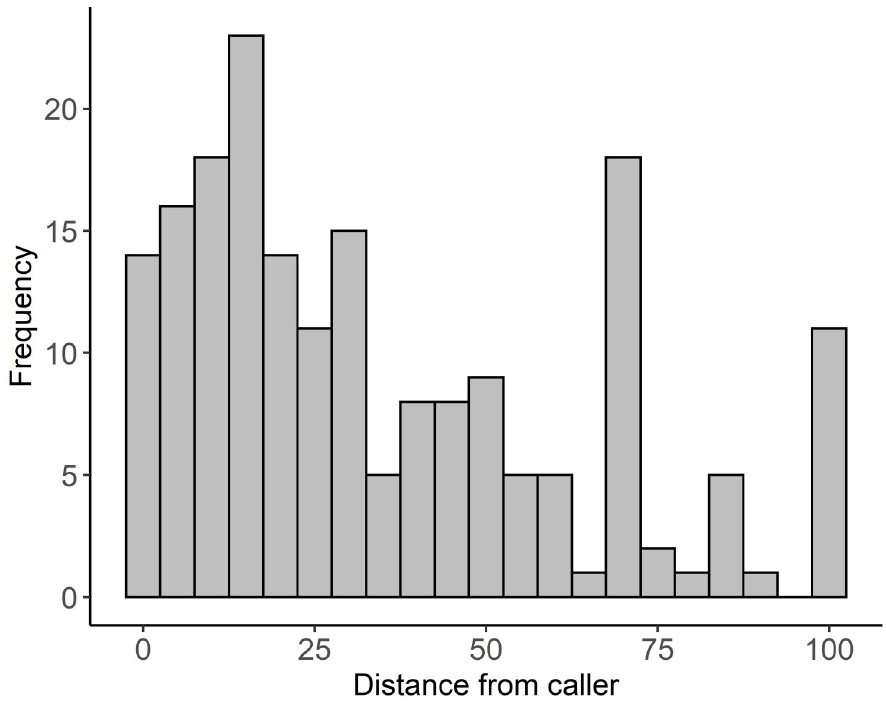
Fig 3. Frequency of quail detection with respect to the distance from the ‘quail caller’ (10 m